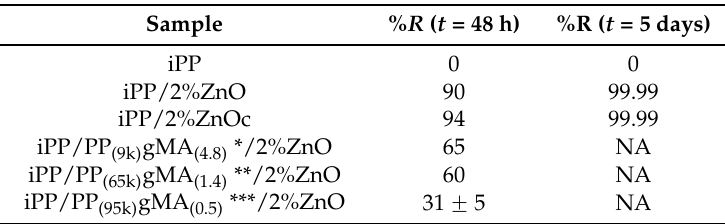
Table 6. Percent reduction of E. coli at 48 h and 5 days of contact for iPP and different films at 2% ZnO, (adapted from Table 5 of this paper and references [22,24]).